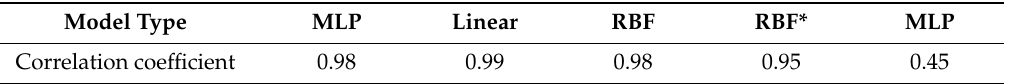
Table 3. Correlation Coe ffi cient for Individual Types of Generated Neural Networks [Own Source].